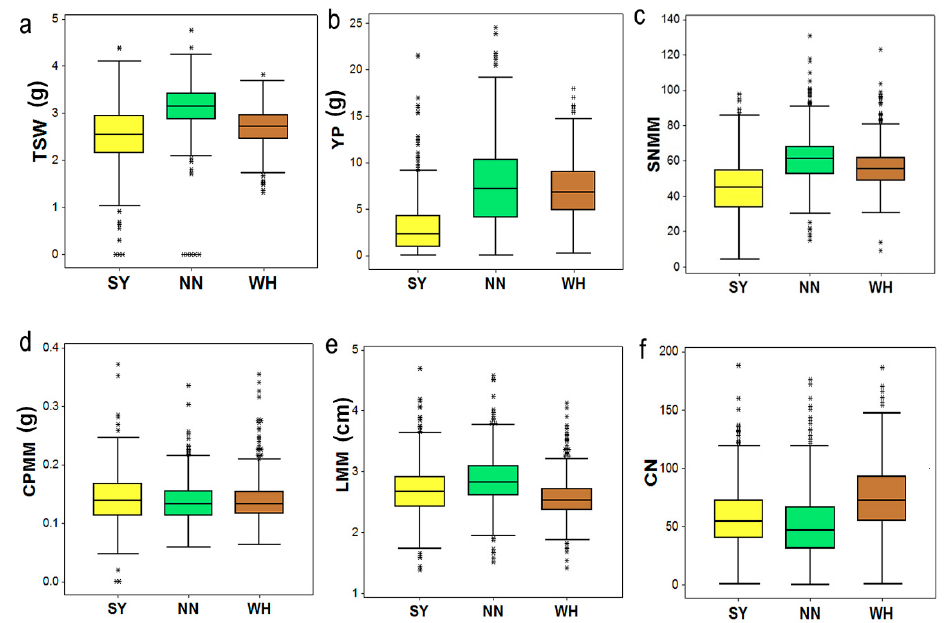
Figure 1. Boxplots displaying variation of six traits across three different environments (SY = Sanya,